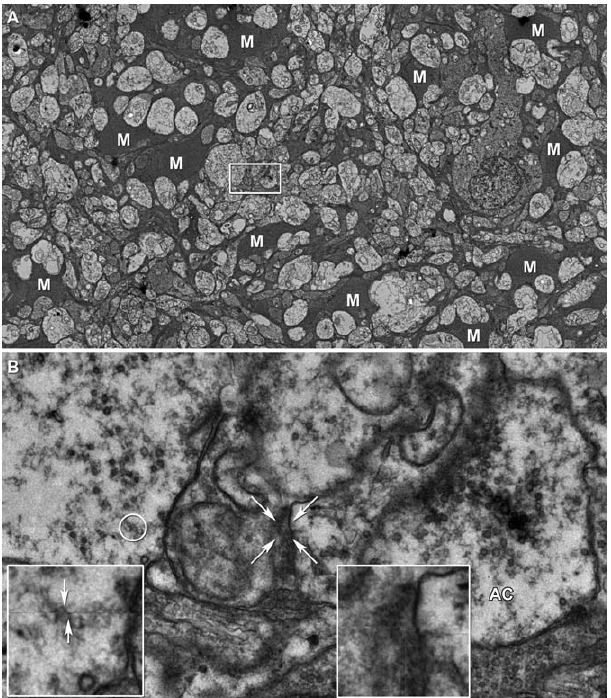
Figure 6. Representative Tile Overlaps Randomly Selected from a 1,000- Tile Array (A) A randomly selected region of rabbit retinal inner plexiform layer displaying parts of section number 105 containing 28 overlapping tiles. The overlaps are invisible at this magnification. Image width ¼ 46.6 l m, M Mu¨ller cell processes. (B) Randomly selected boxed region from (A) containing tile overlaps, width ¼ 4.76 l m. Arrows indicate a corner region among four tiles. A pair of vesicles (circled) is enlarged in the inset at left showing a misalign- ment between upper and lower tiles (arrows) corresponding to 7.8 nm or roughly one-third vesicle. The four corner region (arrows) is enlarged in the inset at right, showing no significant misalignment. The shaded margins of each tile are due to image processing edge enhancements. Most tiles have no measurable misalignment. AC, AC